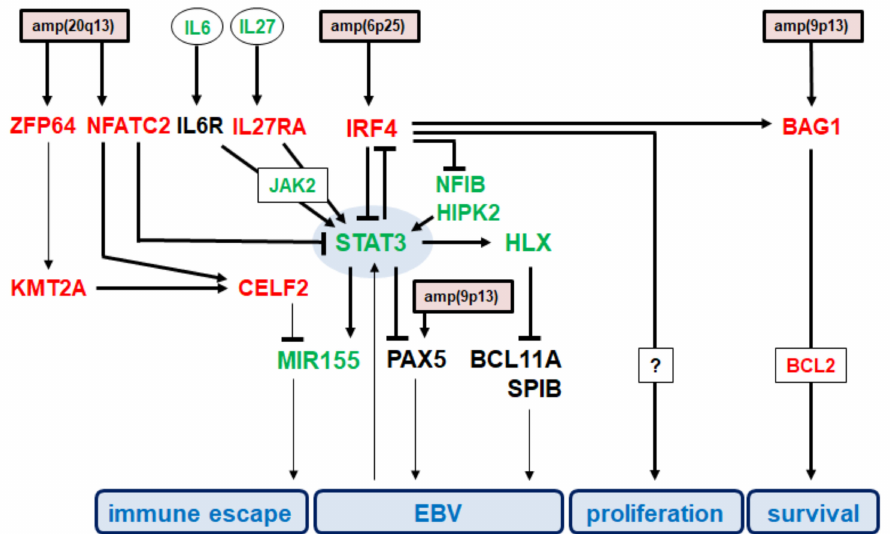
Figure 6. Summary of the results from this study showing a gene regulatory network around STAT3. Genomic amplifications targeting particular genes are highlighted by a red background. Elevated genes are indicated in red, low level expressed genes in green while medium level expressed genes are shown in black. Functional consequences including immune escape, EBV activity, proliferation and survival are highlighted by a blue background. Bold lines indicate relationships demonstrated in this study while slight lines refer to published